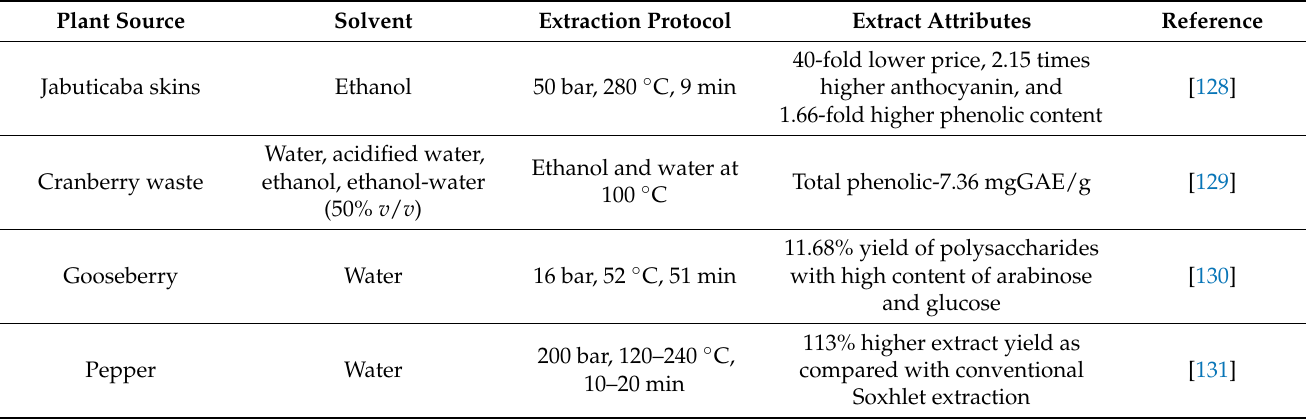
Table 5. Pressurized liquid extraction of bioactive compounds from plant biomass. Plant